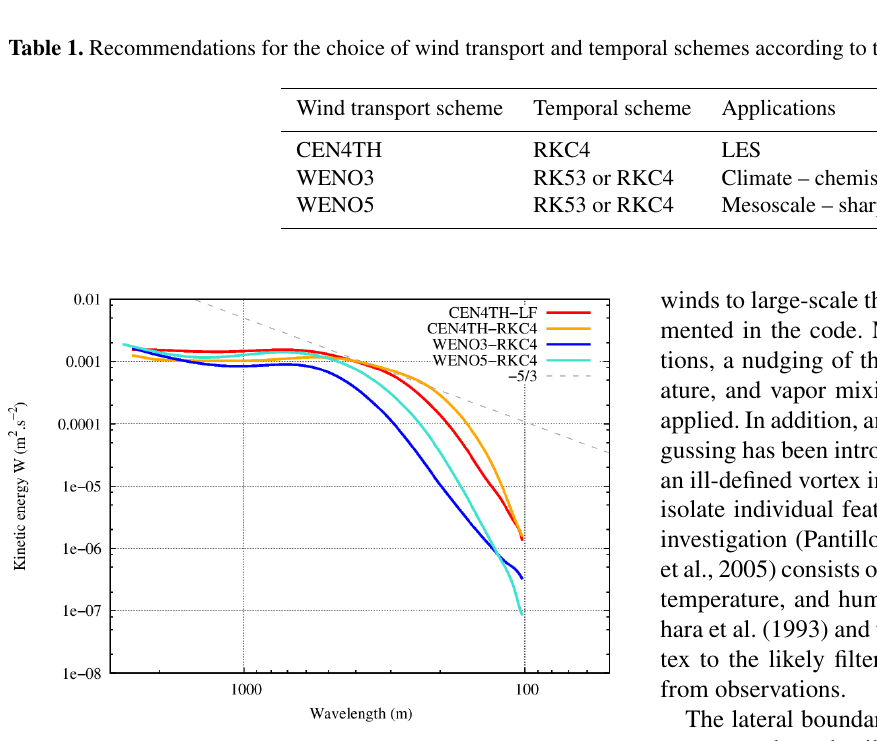
Figure 4. FIRE stratocumulus simulation case ( (cid:49)x = 50m) at 11:00LT (local time) on 14 July 1987: mean kinetic energy spec- tra for the vertical wind computed in the boundary layer (between 0 and 1100m) with different numerical schemes for the wind trans- port. The dashed line indicates the power law with an exponent of − 5 / 3 (the Kolmogorov